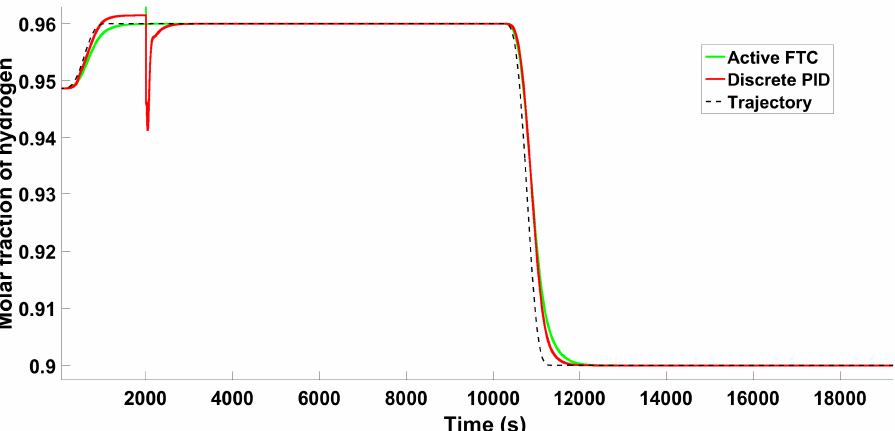
Figure 13. Scenario 1 − Ramp-type fault: Comparison between the discrete PID controller and the FTC applied to the reduced model (Hammerstein − Wiener) for controlling the hydrogen purity with trajectory changes and ramp-type